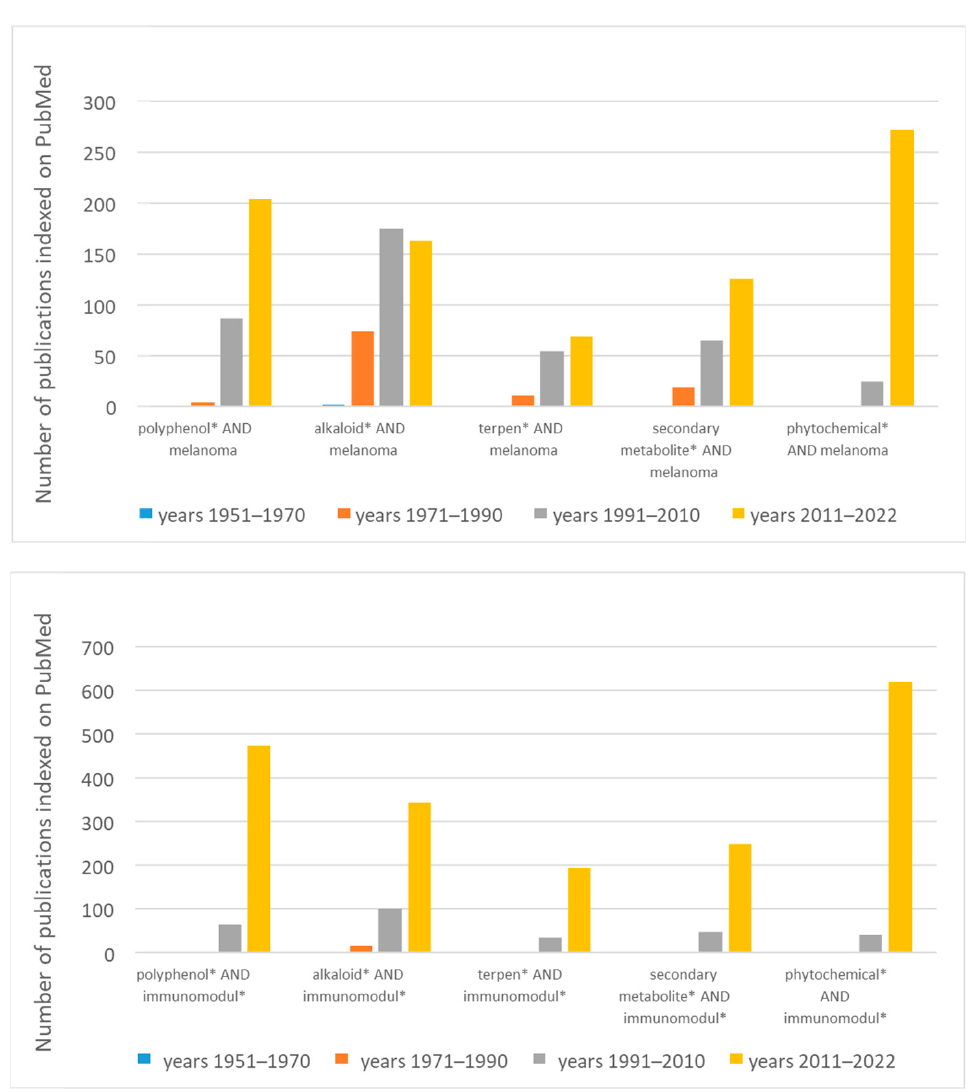
Figure 1. Number of publications indexed on PubMed is reported on four groups: those published between 1951–1970, 1971–1990, 1991–2010 or from 2011 up today (2011–2022: please note that the last one refers to only 11 years), filtered by containing within title/text the name of a category of natural compounds. In upper panel the second search criterion was “melanoma” while in the lower panel the second criterion was